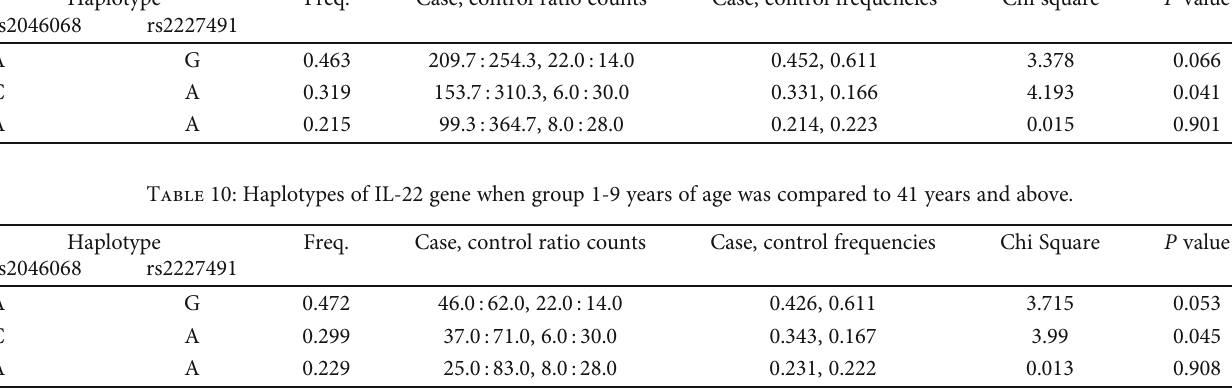
Table 9: Haplotypes of IL-22 gene when group 1-9 years of age was compared to 10 years and above. Haplotype Freq.